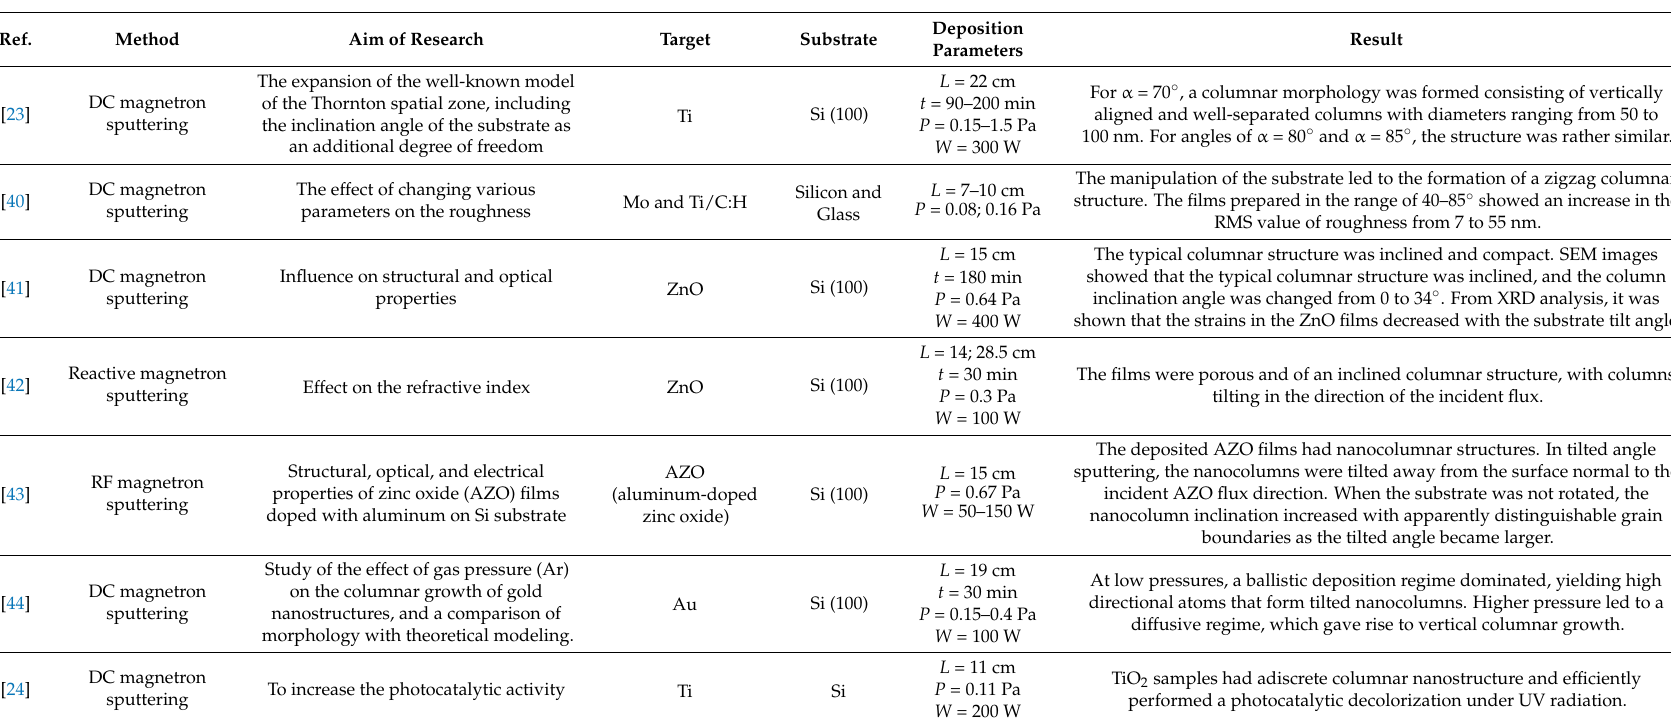
Table 1. Deposition parameters and coating properties for glancing angle deposition (GLAD) with magnetron sputtering from the literature.